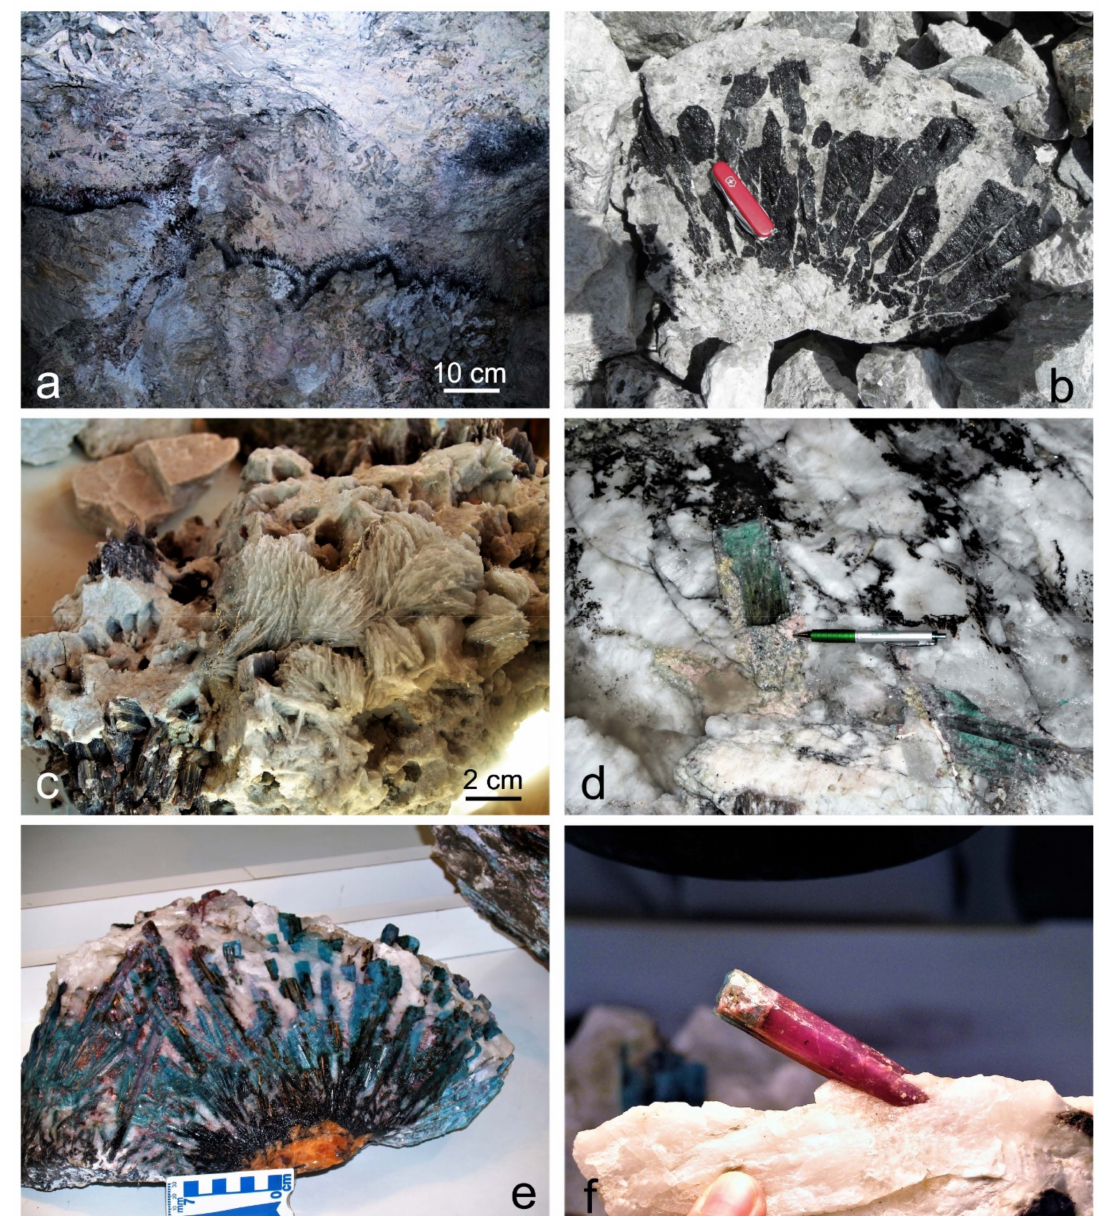
Figure 3. Macrophotographs showing: ( a ) A several-centimeters-thick tourmaline front, Zone I; ( b ) Comb-textured tourmaline intergrown within medium-grained albite and quartz, Zone I; ( c ) Mineral association composed of cleavelandite (albite), muscovite, and lepidolite; ( d ) Beryl crystals embedded within a lepidolite envelopment at the contact between Zones III and IV; ( e ) Transition from schorl to blue-colored tourmaline; ( f ) Red-colored tourmaline from the Boqueir ã o granitic